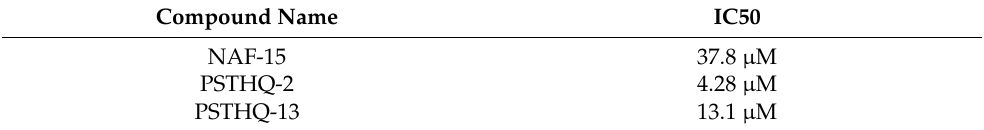
Figure 2. TDP1 activity after treatment with molecular compounds. ( a ) Illustration of the TDP1 activity assay using a hairpin DNA substrate with a quencher (Q: BHQ-1) in the 3′-end and a fluorophore (F: ATTO488) in the 5′-end (i). TDP1 removes the quencher (ii) followed by release of the TDP1 protein, now capable of participating in a new cycle (iii). Removal of the quencher allows for light development of the fluorophore. Fluorescence development is measured over time. ( b ) Example of a curve representing measurement of fluorescence development over time. The slope of the initial linear phase is a representation of the TDP1 activity assay visualized as a columns chart in c. ( c ) TDP1 activity for purified TDP1 enzyme after treatment with potential TDP1 inhibitors. All potential TDP1 inhibitors had a final concentration of 80 µ M. DMSO control contained 1.6% DMSO, which is the same DMSO amount as in the samples with potential TDP1 inhibitors. All data were normalized to DMSO control. *** Represents a p -value < 0.001 compared to the DMSO control. Table 1. IC50 values for the three compounds with significant inhibitions of TDP1 activity.